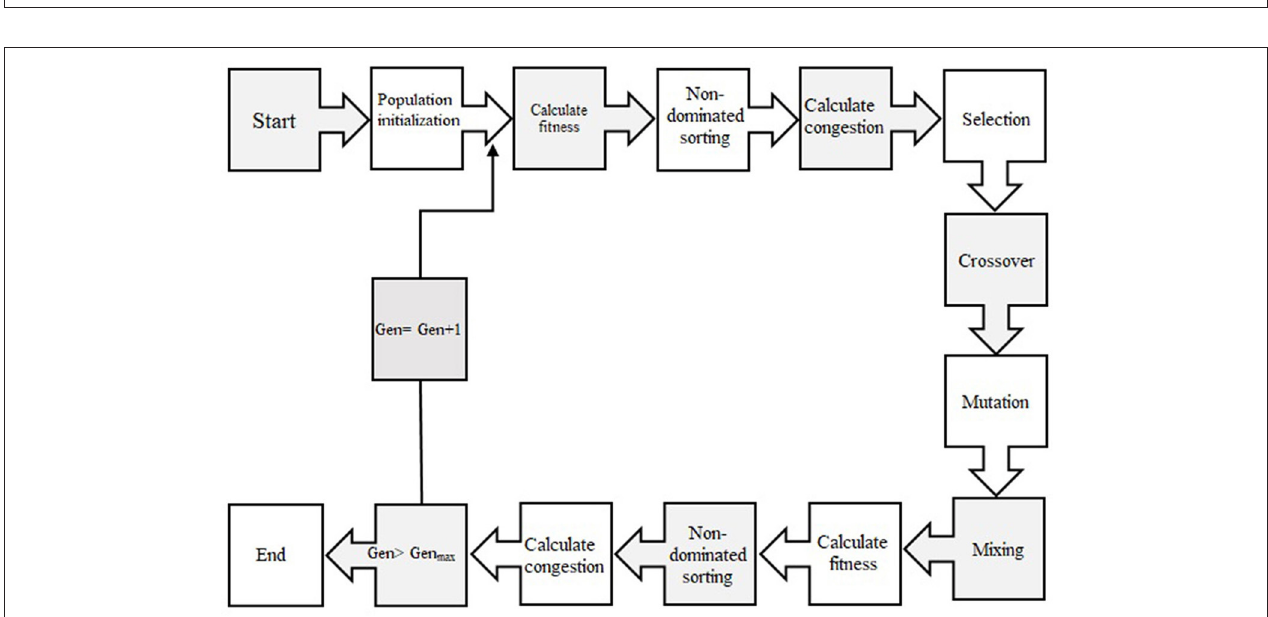
FIGURE 2 | Schematic diagram showing the step-by-step NSGAII optimization process.